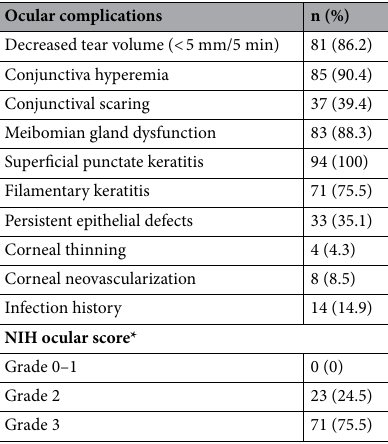
Table 1. Clinical characteristics of patients with chronic ocular graft-versus-host disease. NIH National Institute of